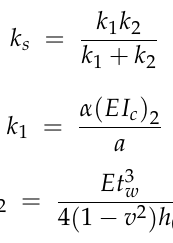
Figure 9. Models used by the standards: ( a ) Partially restricted beams [105,106]; ( b ) Inverted U-frame model [107].